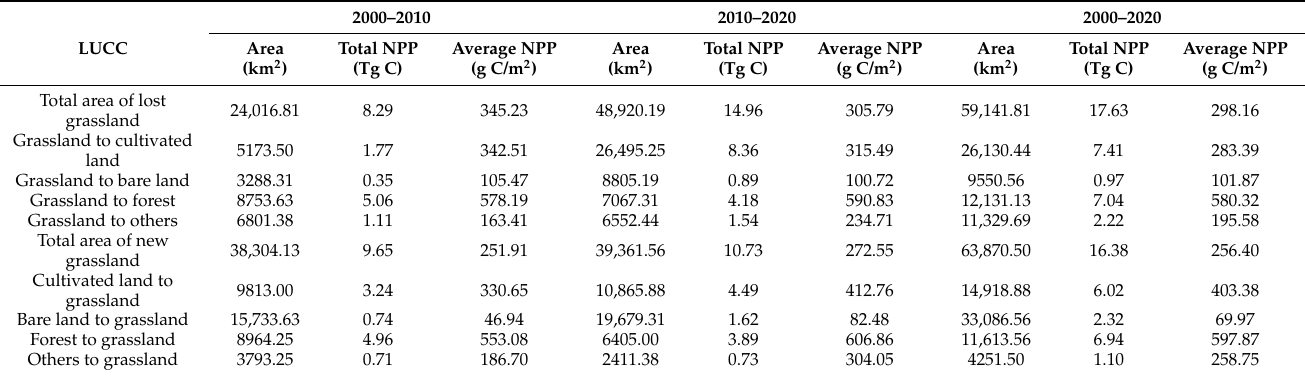
Table 6. Changes of grassland NPP in Inner Mongolia based on the different land-use changes during 2000–2010, 2010–2020, and 2000–2020.